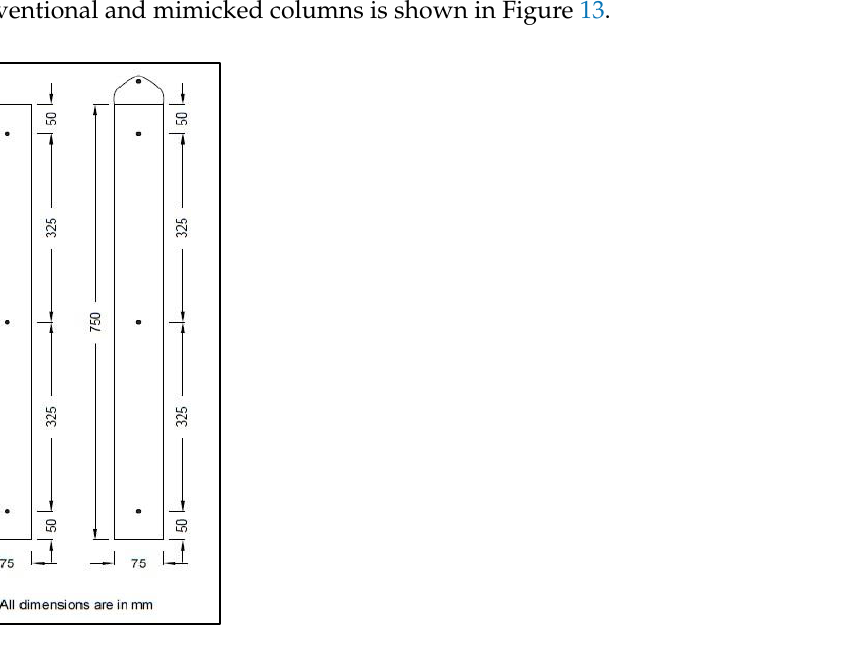
Figure 12. Fabricated mimicked mold. ( a ) Overall view. ( b ) Open view.